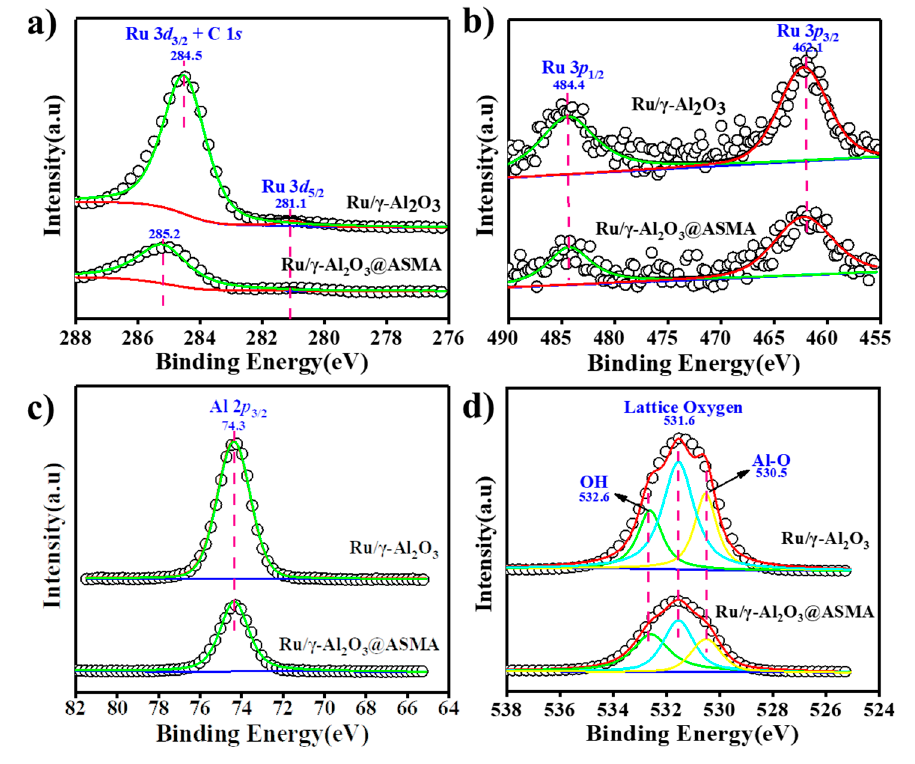
Figure 5. XPS spectra of ( a ) Ru 3d , ( b ) Ru 3p , ( c ) Al 2p, and ( d ) O 1 s for the 5% Ru / γ -Al 2 O 3 and 5% Ru / γ -Al 2 O 3 @ASMA.